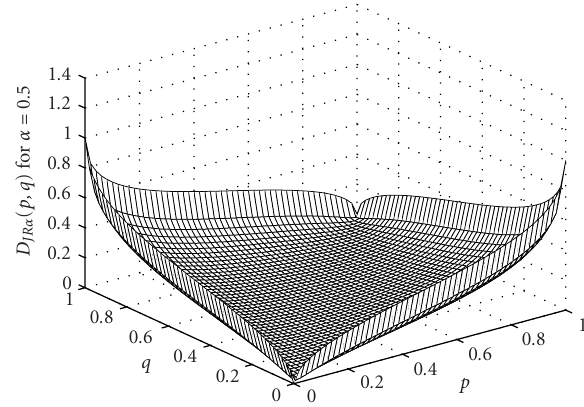
Figure 8: Three-dimensional representation of Jensen-R´enyi diver- gence D JR α ( p , q ), where p = ( p ,1 − p ), q = ( q ,1 − q ), π = (0 . 5,0 . 5), and α = 0 .